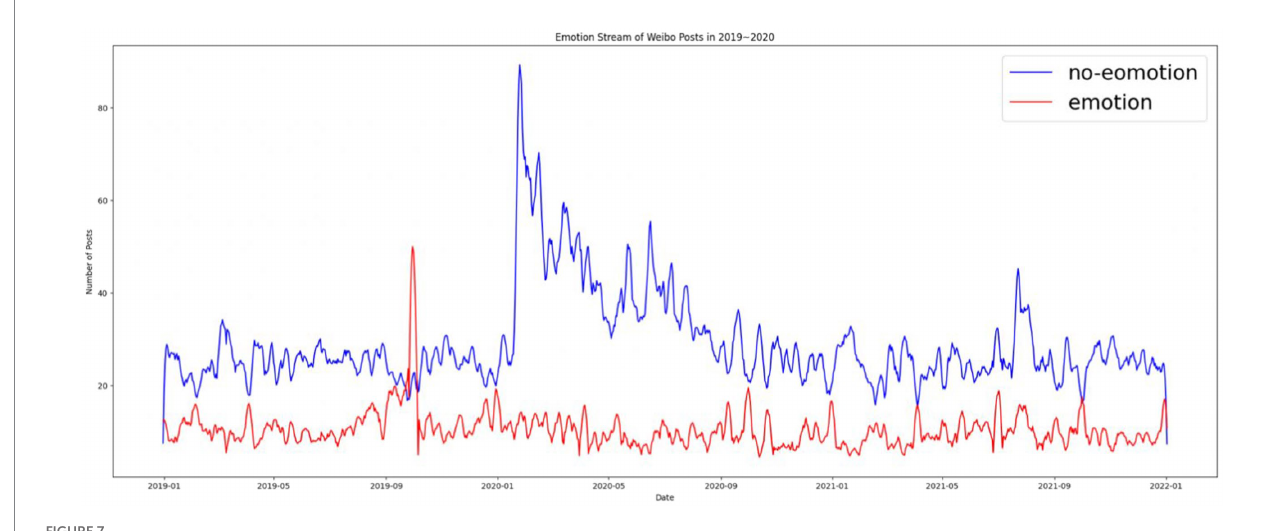
FIGURE 7 Emotional and nonemotional news on People’s Daily Weibo account from 2019 to 2021.